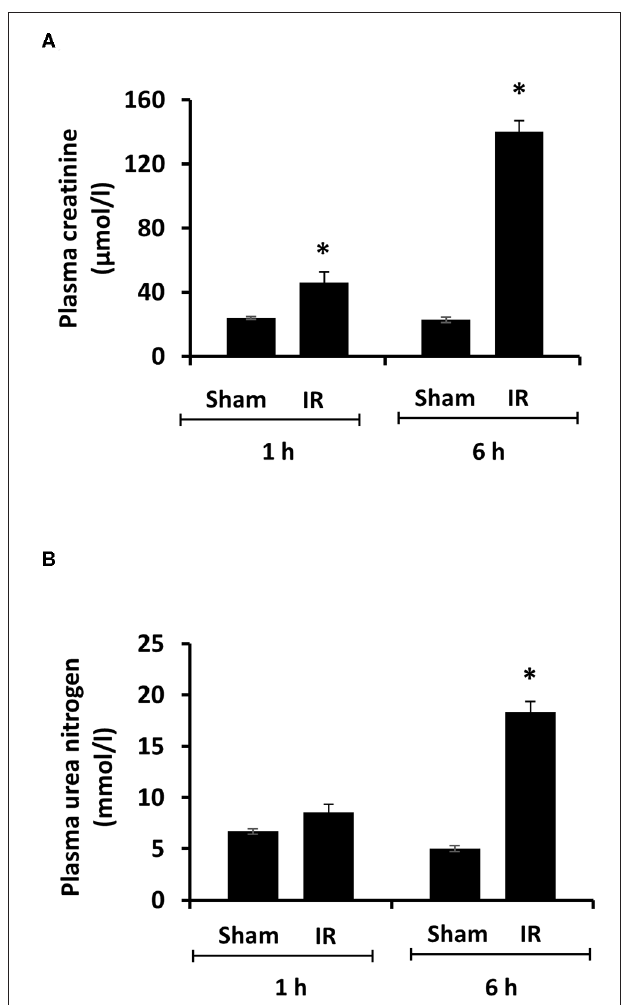
FIGURE 1 | Effect of kidney ischemia-reperfusion on kidney function. The left kidney of rats was subjected to 45min ischemia followed by 1 hour (1h) or 6 hours (6h) of reperfusion (IR). As a control, rats were subjected to a sham-operation without inducing ischemia (Sham). Plasma creatinine (A) and urea nitrogen (B) were measured. Results are expressed as mean ± SE ( n = 5 for each group). * p < 0.05 when compared with the value obtained from the sham-operated